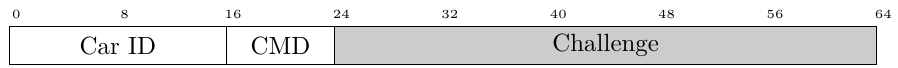
Figure 5: The structure of LF frames transmitted by the car. The 2-byte car ID is followed by a command byte, in case of a response request an additional challenge is